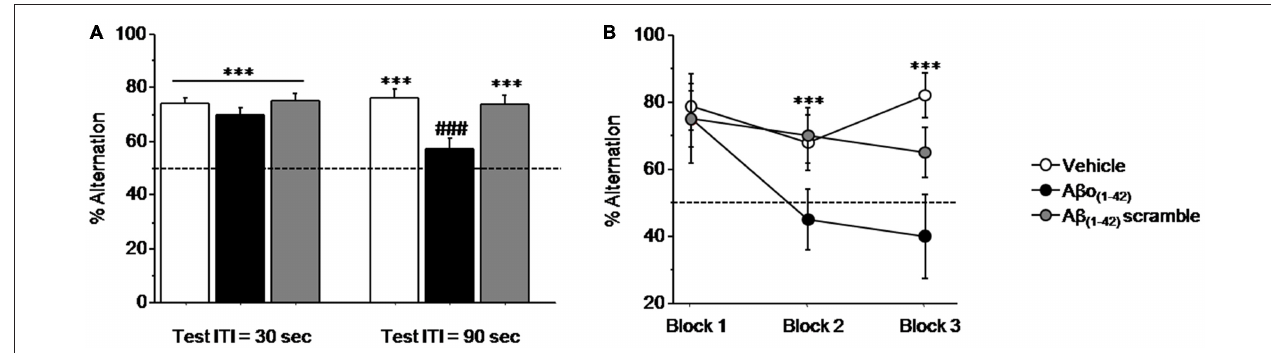
FIGURE 3 | Intra-CA1 A β o ( 1 – 42 ) treatment decreases working memory performance in a sequential alternation task in T-maze . Percentage alternation performance were measured during pre-test (ITI = 30 s) and test (ITI = 90 s) sessions on Vehicle ( n = 18), A β o ( 1–42 ) ( n = 10) and A β ( 1–42 ) scramble ( n = 10) groups. (A) Alternation performance were impaired in the A β o ( 1–42 ) group during the test session compared with Vehicle and A β scramble groups. (B) Two trials blocks analysis indicated that alternation performance of A β o ( 1–42 ) group was impaired during successive trials. vs. 50% chance level ∗∗∗ p < 0.001; Between-group comparisons ; ### p <